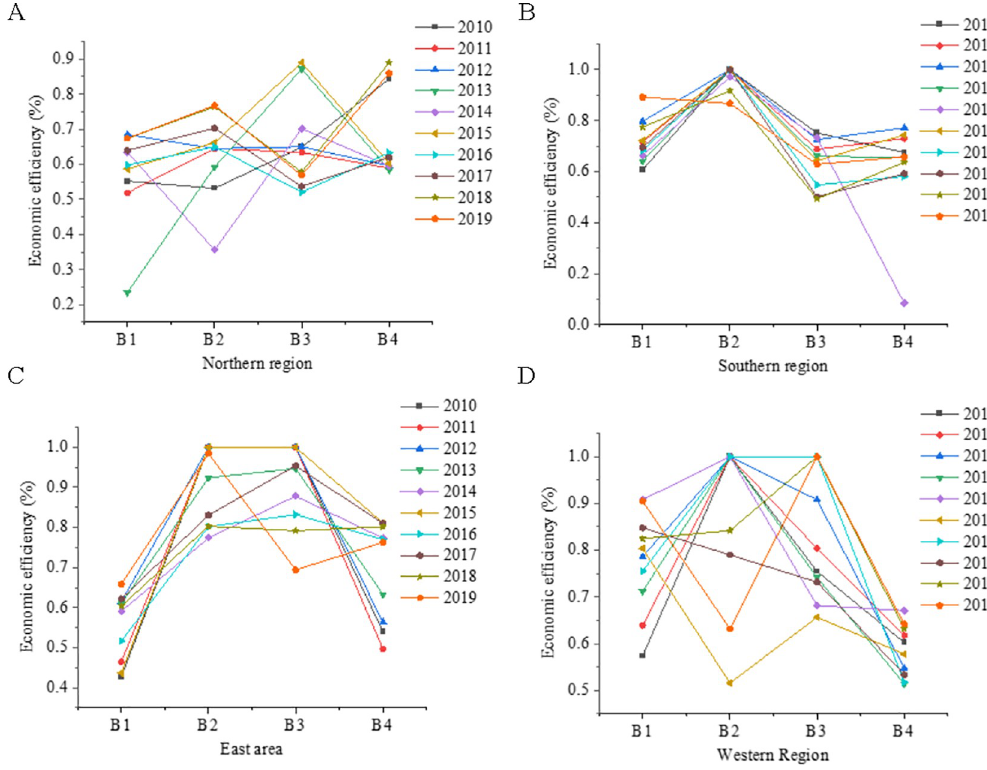
Fig 6. Comprehensive efficiency results of high-tech IDZs in different years and different